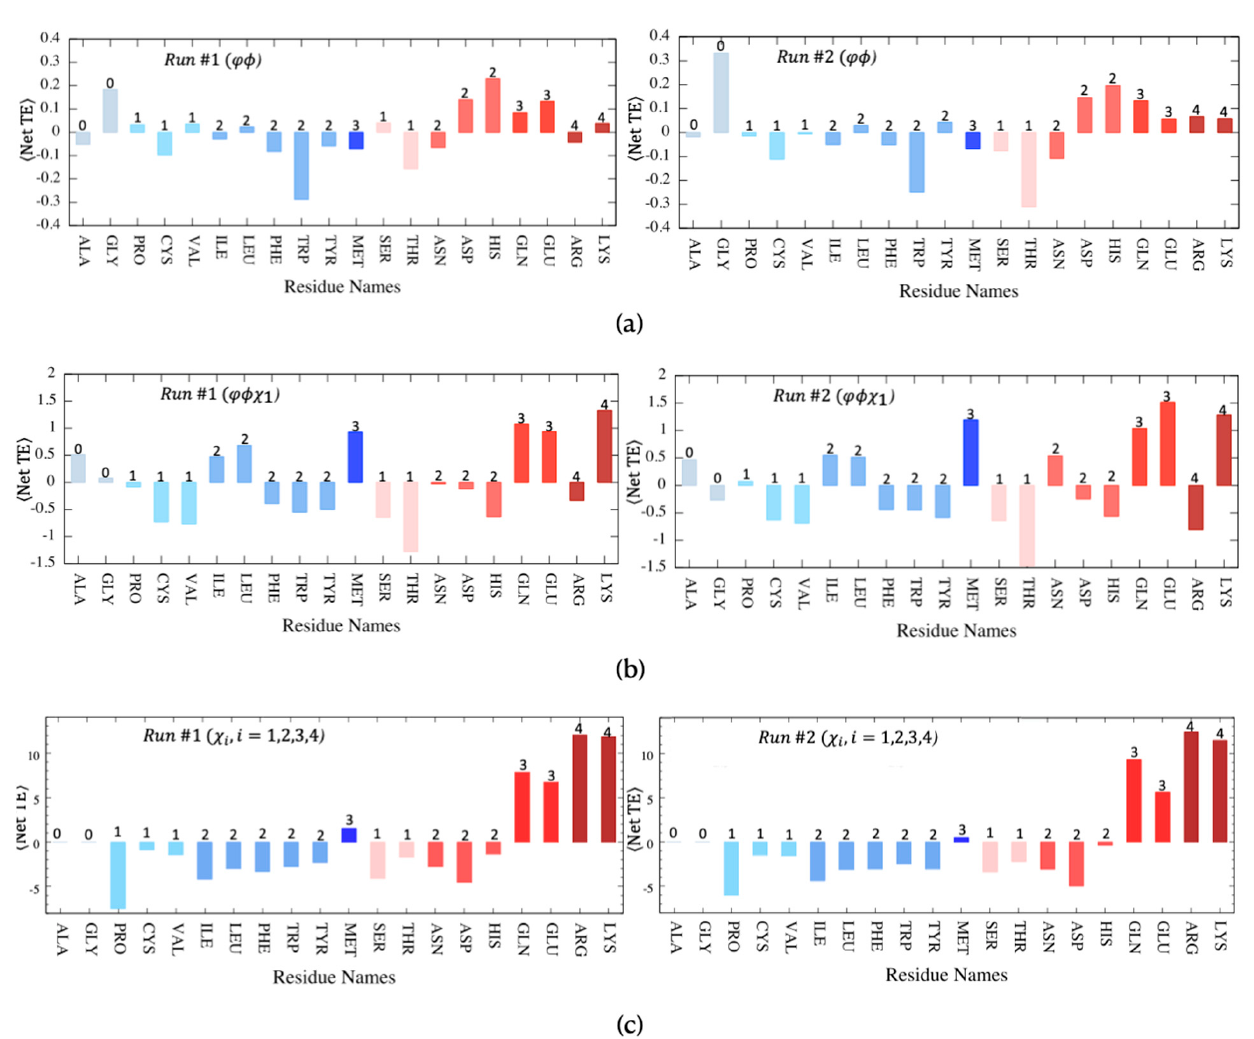
Figure 7. Net transfer entropy averaged for each residue type categorized as either hydrophobic (blue tones) or polar (pink tones). The number of side-chain torsion angles k indicated at the top of each bar is determined for both MD runs using ( a ) backbone torsion angles, ( φ , ψ ) , ( b ) backbone torsion angles, ( φ , ψ ) and the first side-chain torsion angle ( χ 1 ) and ( c ) all possible side-chain torsion angles 𝜒 (cid:3038) , 𝑘 = 1,2,3,4 .